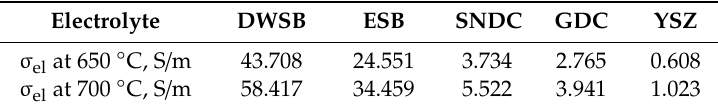
Table 2. Ionic conductivities of di ff erent